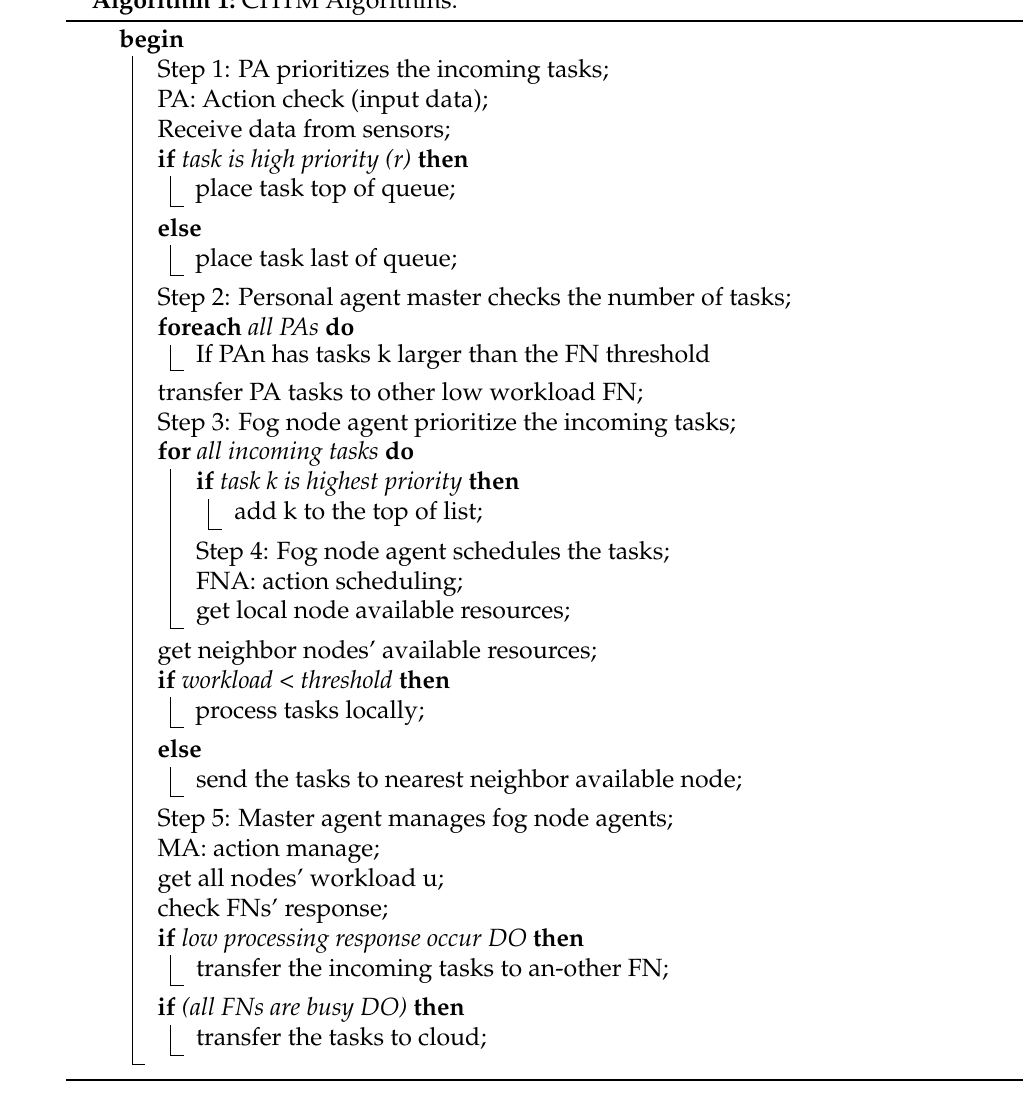
Algorithm 1: CHTM